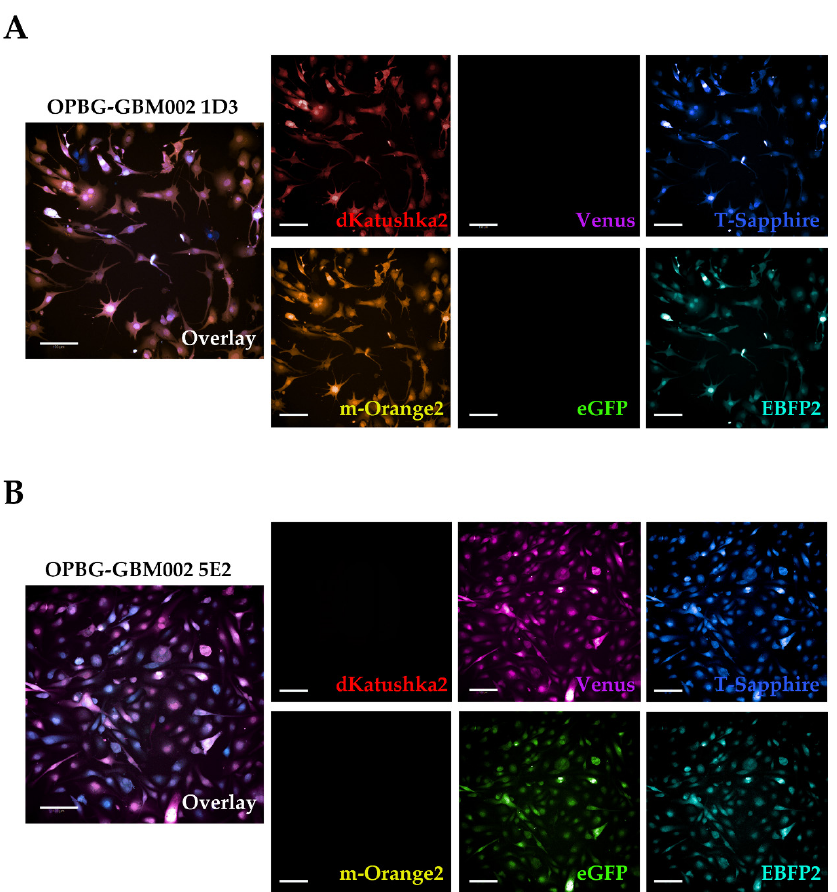
Figure 6. pGBM and DIPG optical barcoded single cell-derived clones analyzed on the Operetta CLS. ( A , B ) Representative fluorescent images of two OPBG-GBM002 single cell-derived clones, are shown. The image overlay of the combined fluorescence for the clones, are shown together with the split for the six fluorescent proteins. The clone 1D3 ( A ) appeared positive to dKatushka2 (red), m-Orange2 (yellow), T-Sapphire (blue) and EBFP2 (cyan), and the clone 5E2 ( B ) appeared positive to Venus (magenta), eGFP (green), T-Sapphire (blue), and EBFP2 (cyan). All images were acquired using Operetta CLS fully equipped with 8 different emission filters. Scale bars: 100 μ m.